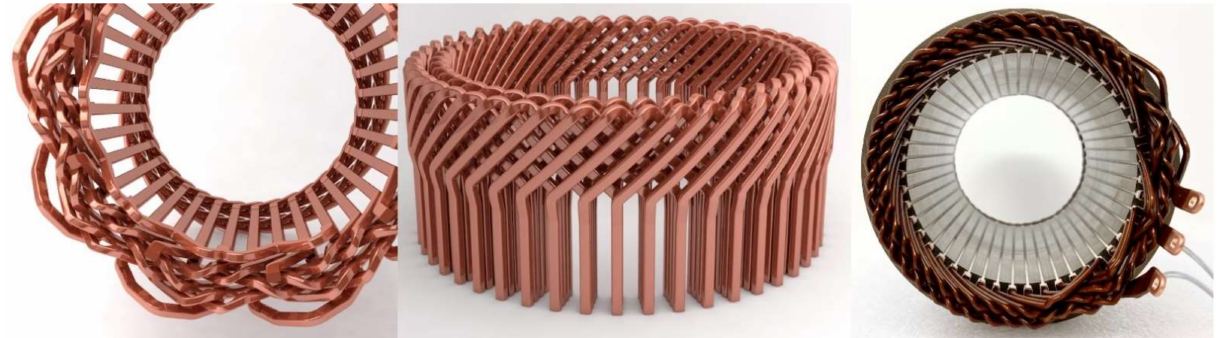
Figure 15. High-performance 3D-printed single coil winding for racing engine [43].